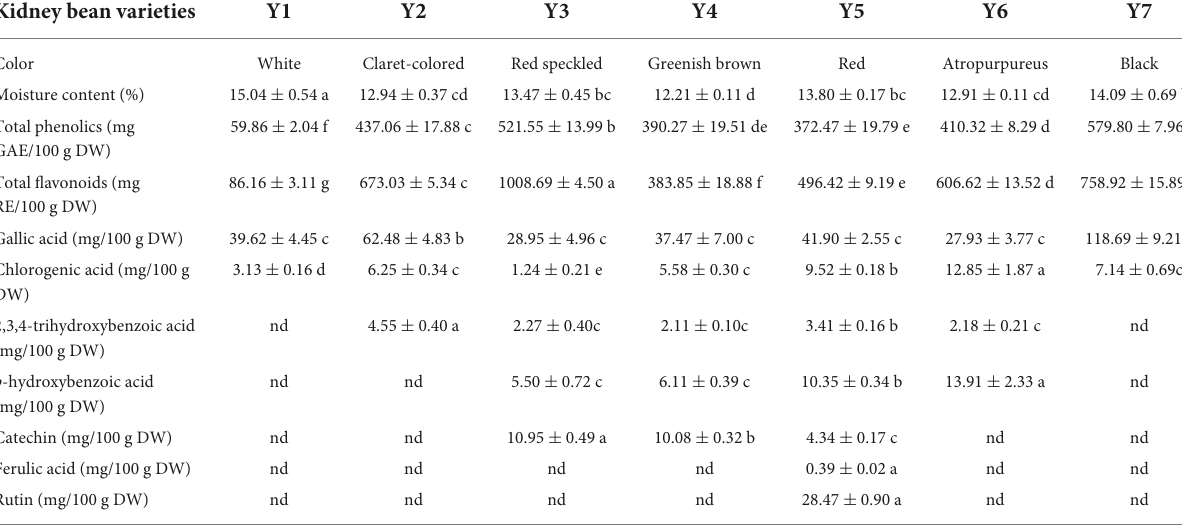
TABLE 1 Moisture content and phenolic compounds composition of kidney